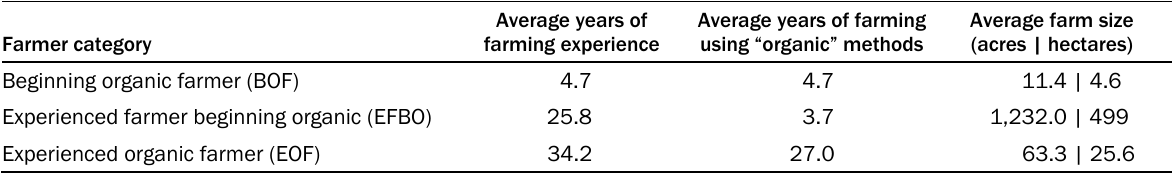
Table 3. Average Years of Farming, Average Years of Farming Using “Organic” Methods, and Average Farm Size